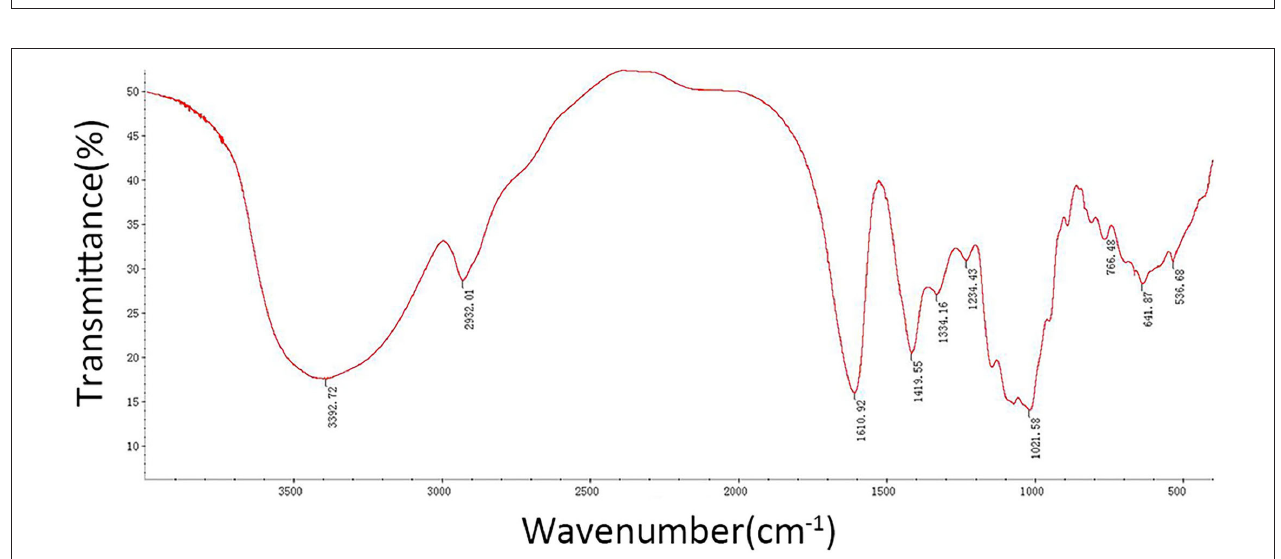
FIGURE 2 | Monosaccharide composition analysis HPLC chromatogram.